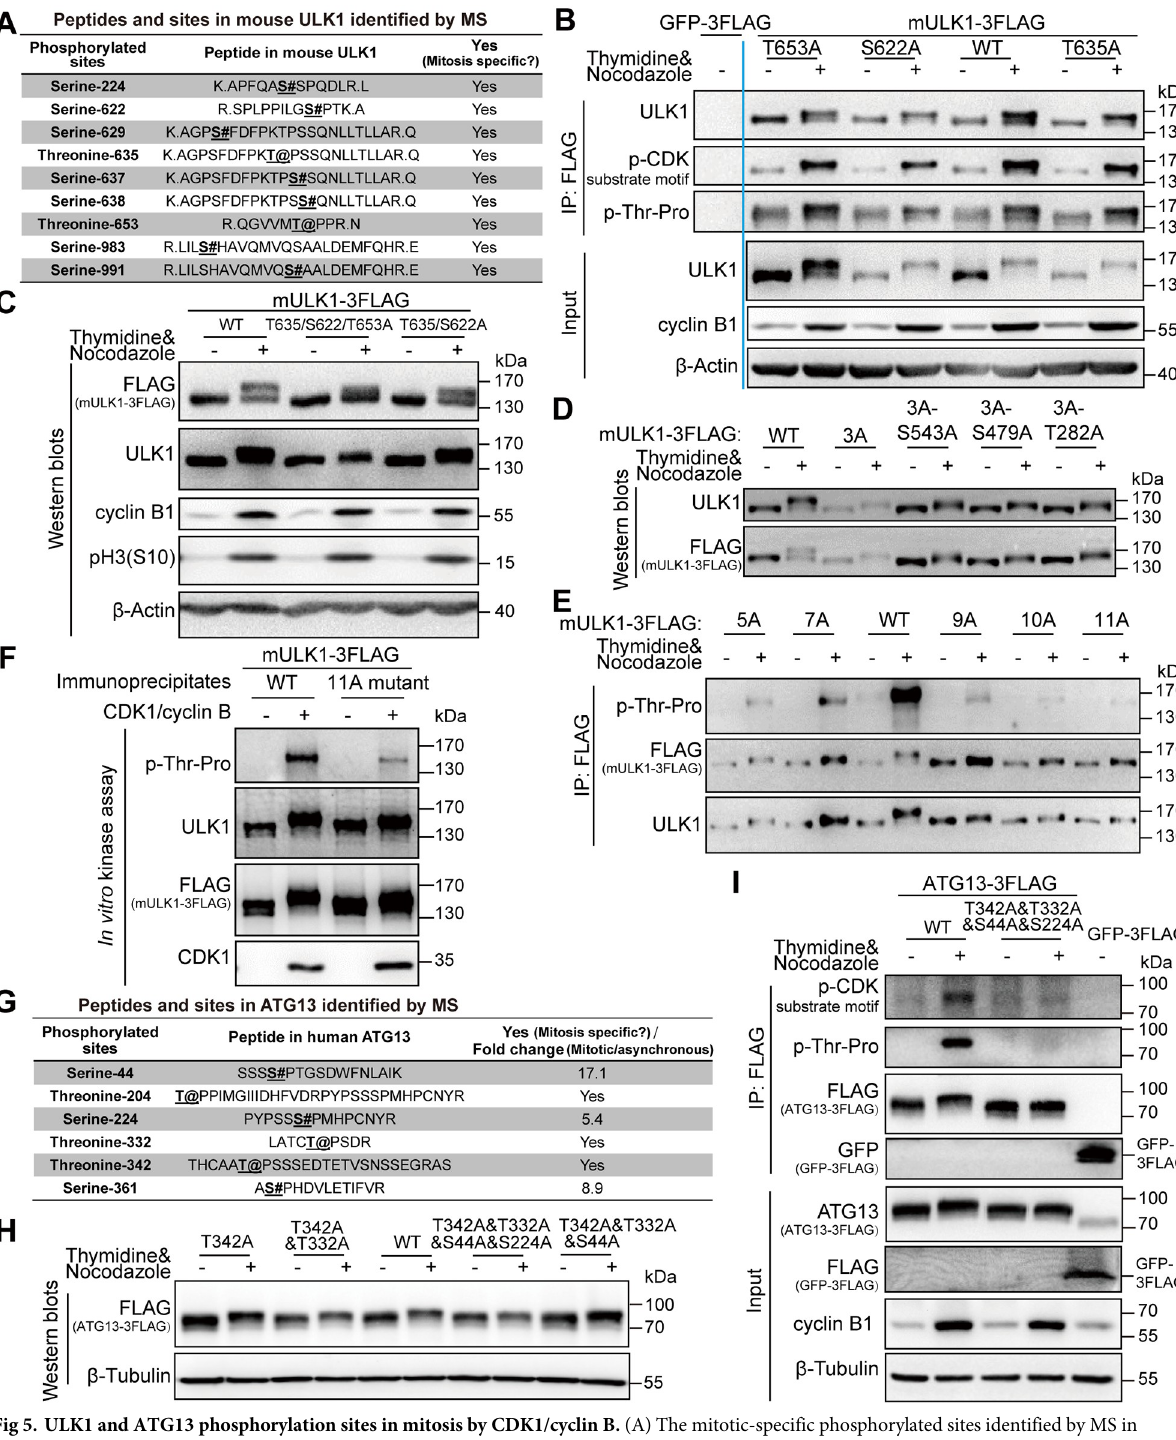
PLOS Biology | https://doi.org/10.1371/journal.pbio.3000288 June 9, 2020 11 /